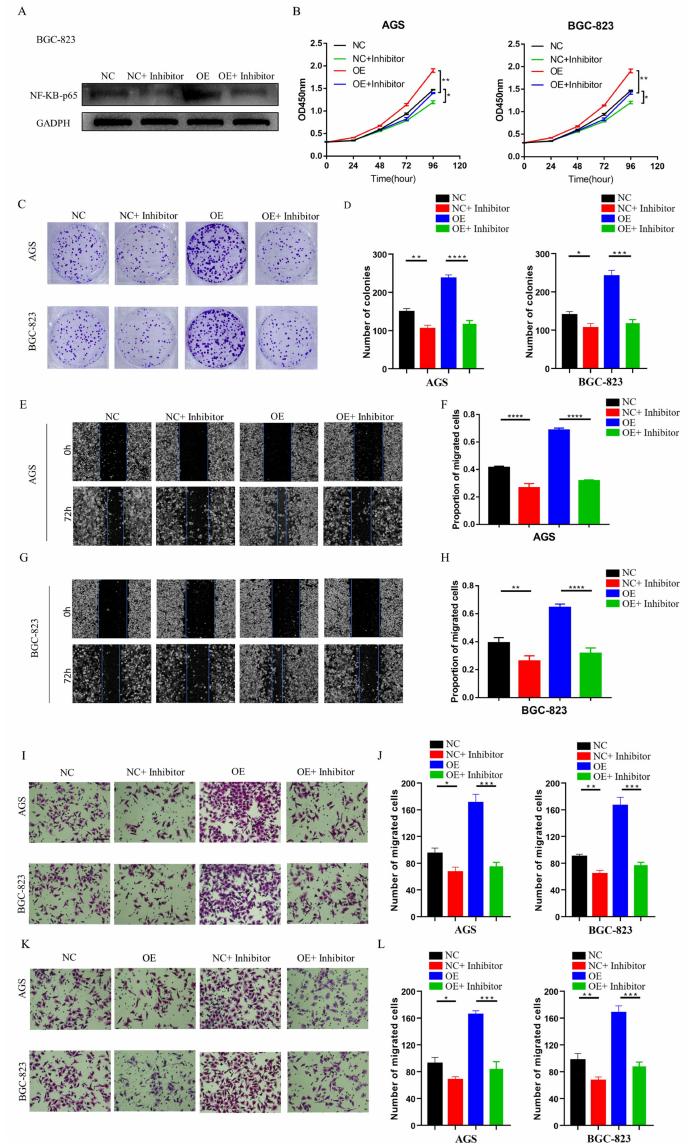
Figure 6. Blocking the NF- κ B pathway reverses LINC01537-induced GC progression in vitro. Western blot ( A ) analysis of the protein levels of NF- κ B in NC or OE (LINC01537-overexpression BGC-823 administrated with NF- κ B inhibitor or not) (source data can be found at Table S11). CCK8 assays ( B ) and colony assays ( C , D ) were used to detect whether administration of NF- κ B inhibitor could inhibit the increased proliferation and tumorigenesis ability induced by LINC01537 overexpression.